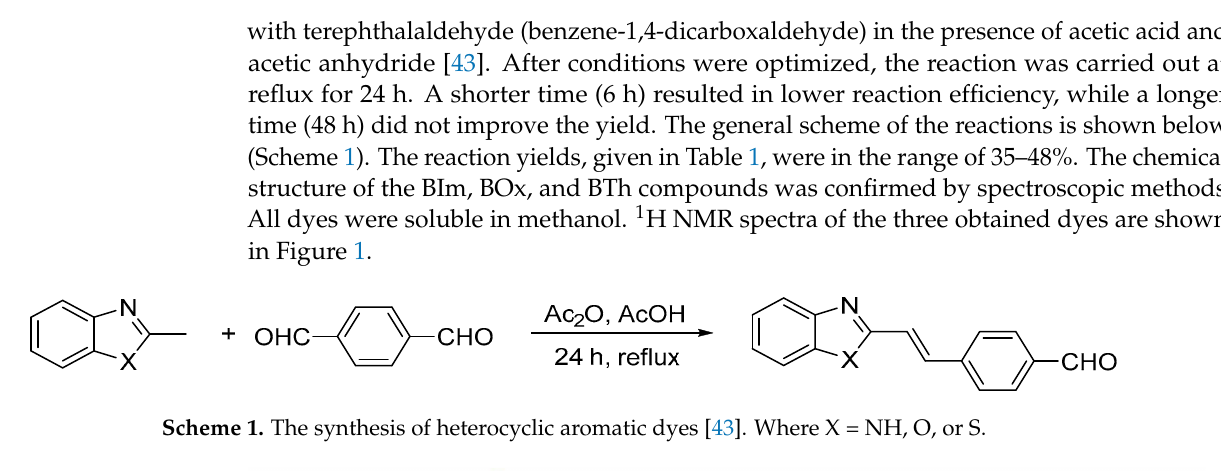
Table 1. The abbreviations, chemical structures, two alternative names, and reaction yields of obtained dyes. (a)